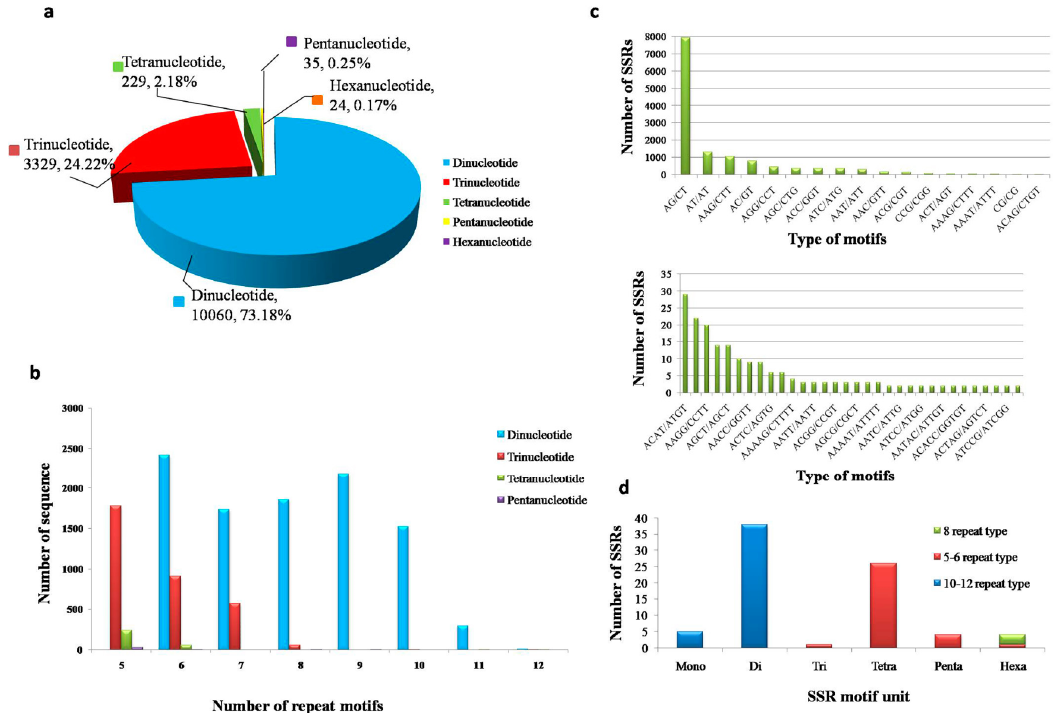
Figure 5. Characterization of simple sequence repeats (SSRs) in the common walnut ( Juglans regia ) transcriptome. ( a ) Distribution of different SSR repeat motif types; ( b ) number of different repeat motif; ( c ) frequency distribution of major SSRs based on main motif type; ( d ) Distribution of 77 SSR motifs in the J. regia transcriptome.